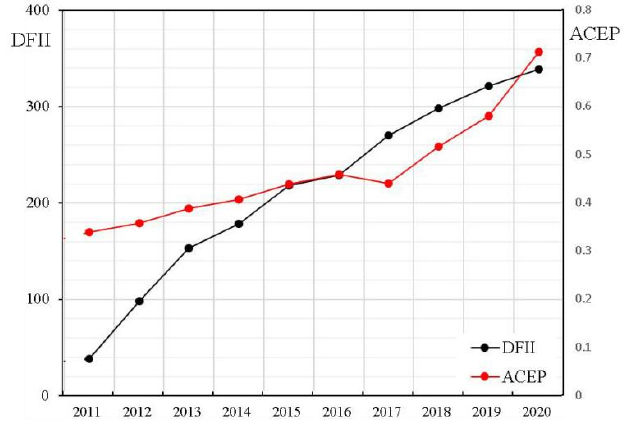
Figure 5. The changing trend lines of DFII and ACEP.